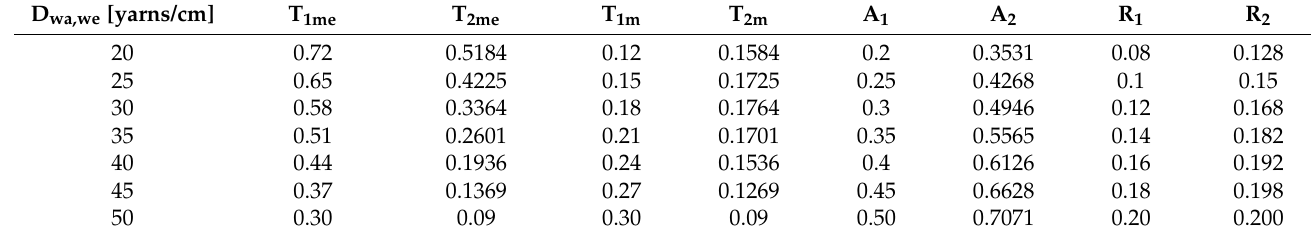
Table 2. Transmission (T me —measured, T m —material), absorption and reflection values for simulated single- and double- layer samples calculated by the simplified model for the prediction of woven fabrics UV properties.